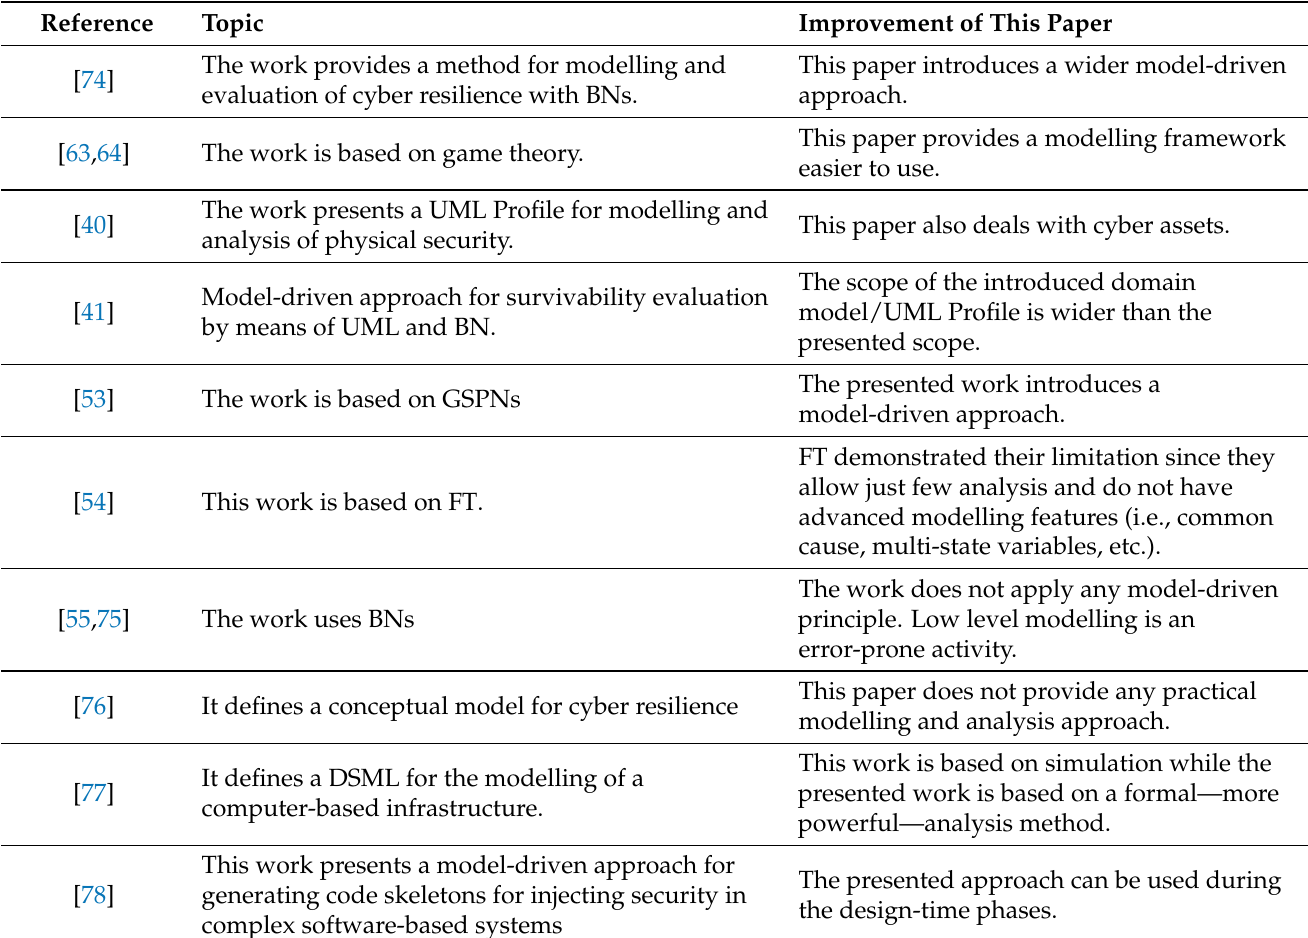
Table 2. This paper vs. related